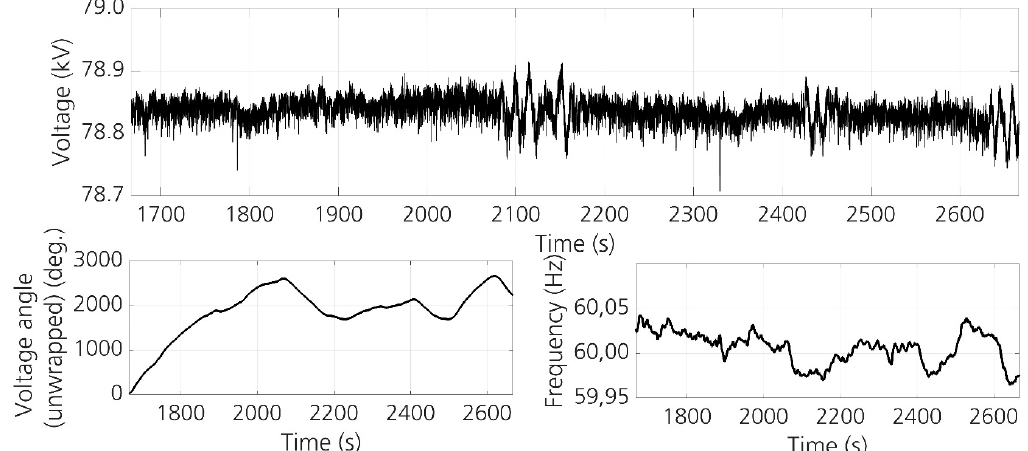
Figure 13. Voltage magnitudes ( top ), voltage angles ( bottom left ) and frequency ( bottom right ) raw signals from the MVField dataset.